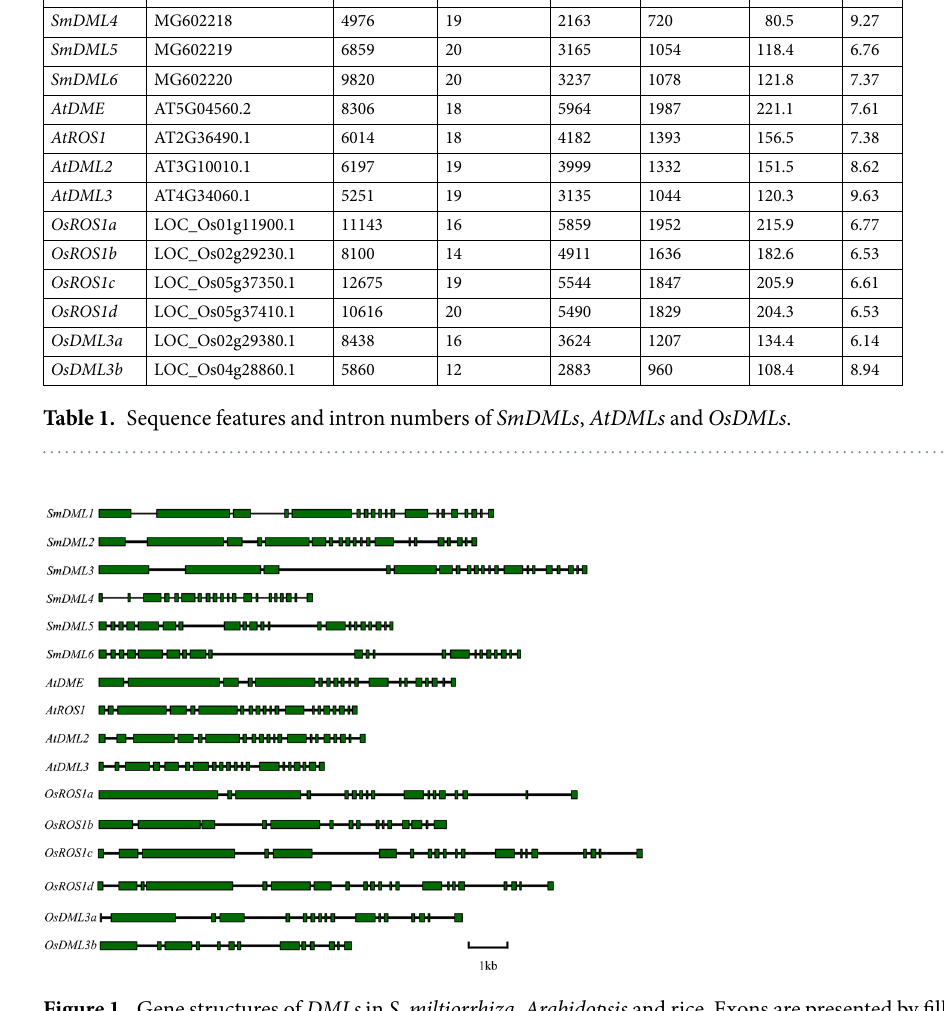
Figure 1. Gene structures of DMLs in S. miltiorrhiza , Arabidopsis and rice. Exons are presented by filled green boxes. Introns are presented by